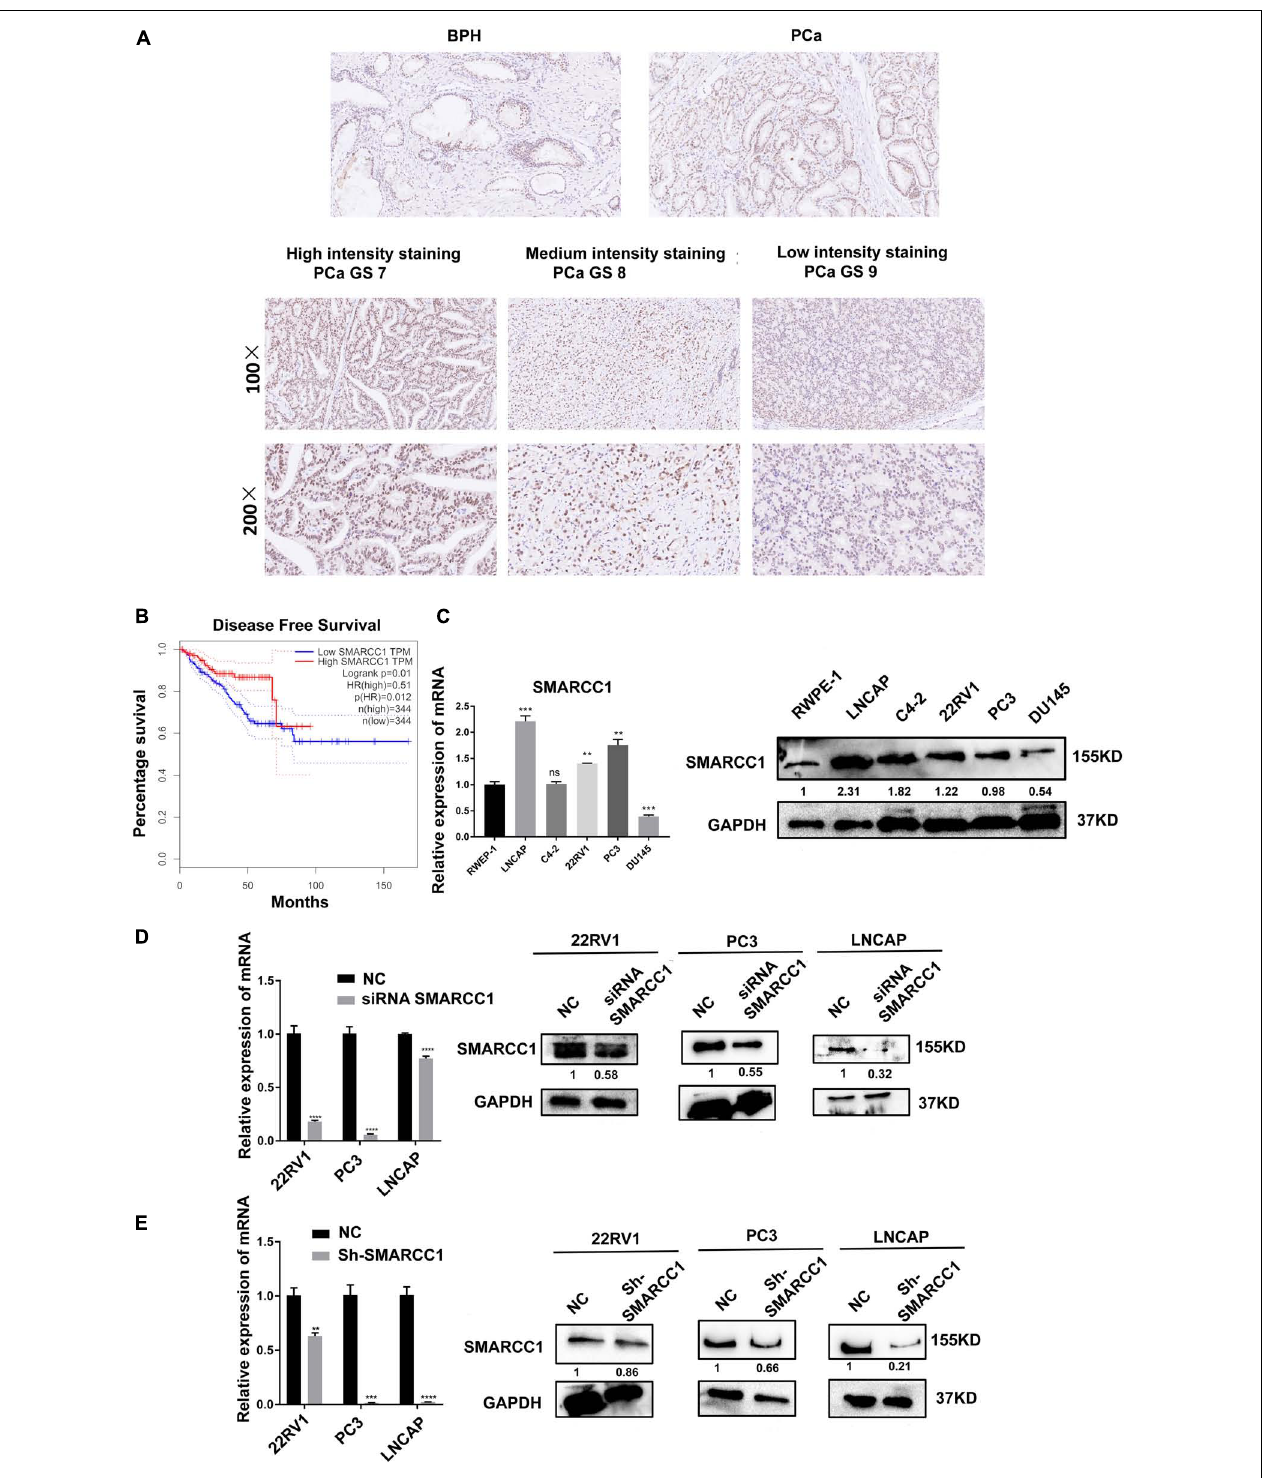
FIGURE 1 | SMARCC1 is downregulated in PCa tissues and correlates with poor prognosis. (A) Representative images of BPH and PCa tissues with Gleason score 7, 8, and 9 showing in situ SMARCC1 expression (magnification, × 100). (B) Disease-free survival of PCa patients with a different SMARCC1 expression from the GEPIA database. (C) Endogenous expression of SMARCC1 mRNA in immortalized normal prostatic epithelial cells and PCa cell lines. (D,E) SMARCC1 mRNA (D) and protein (E) levels in PCa cells transduced with SMARCC1 shRNA lentivirus. Relative mRNA expression levels are shown in the bar graph, and gray density values of proteins are indicated under the corresponding bands. All data are presented as mean ± SEM of at least three independent experiments. *** p < 0.001; **** p < 0.0001.